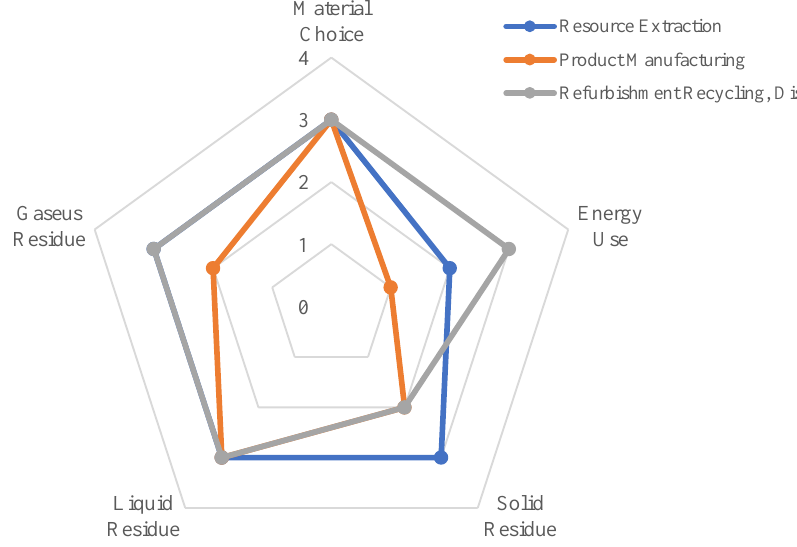
Figure 3. Environmental Responsible Product Assessment for the PCM panel. The use stage was not considered for this study due to missing data.